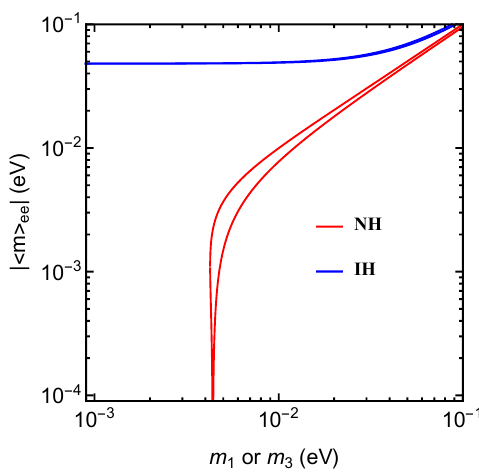
in the NH case or m in the IH 1 3